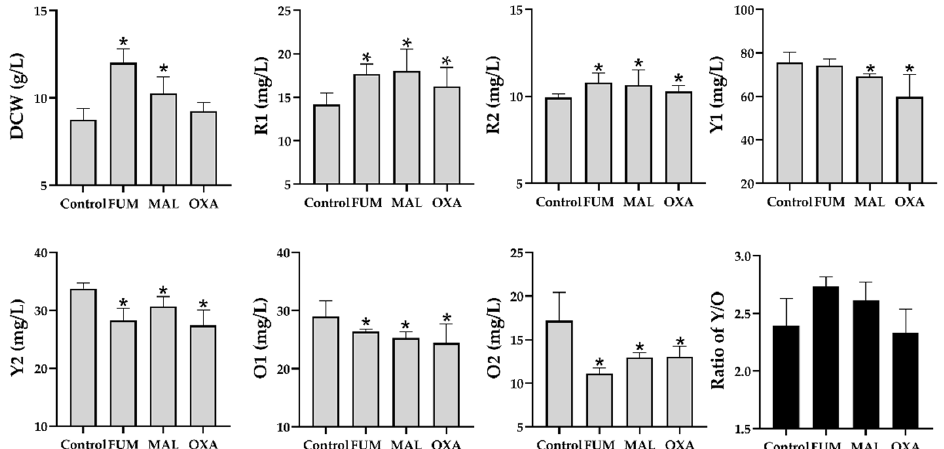
Figure 5. Effects of supplementing biomarkers on the MonAzPs production and mycelia biomass. Each experiment was repeated at least three times. Data were shown as mean ± error bars. Significance of the difference between treated and the control group was analyzed by Student’s t-test. * p < 0.05. MAL, malate; FUM, fumarate; OXA, oxoacetate. Ratio of Y/O was calculated by formula of (Y1 + Y2)/(O1 + O2).